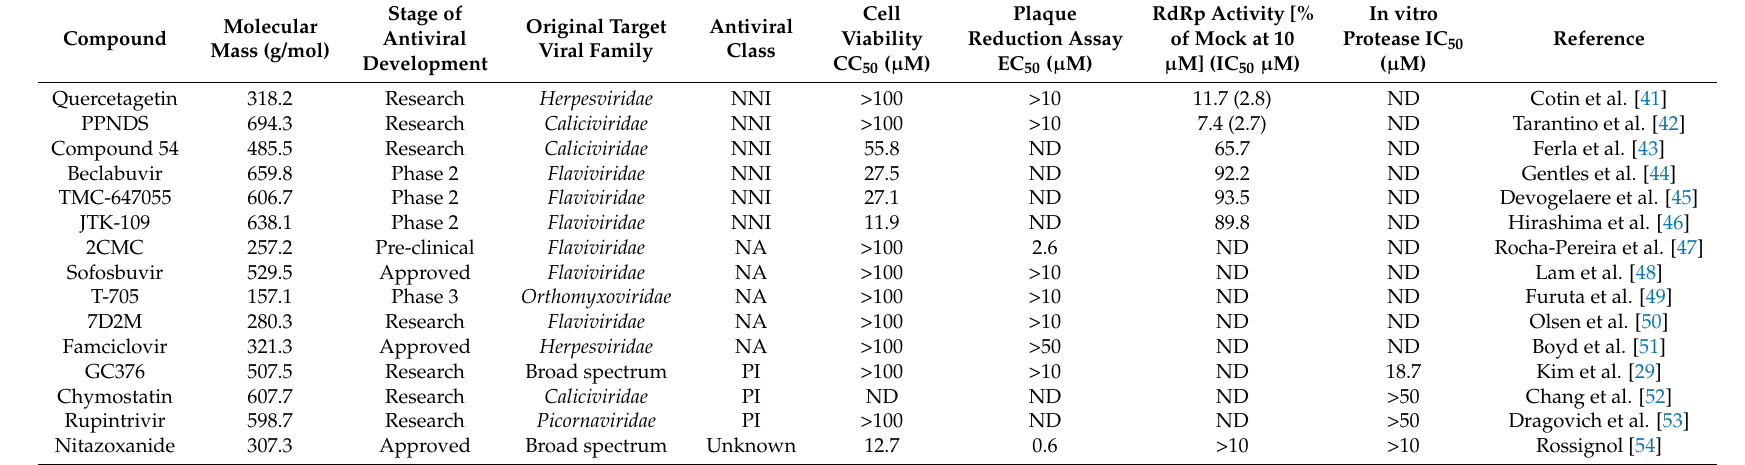
Table 1. The compounds used in this study to test antiviral activity against